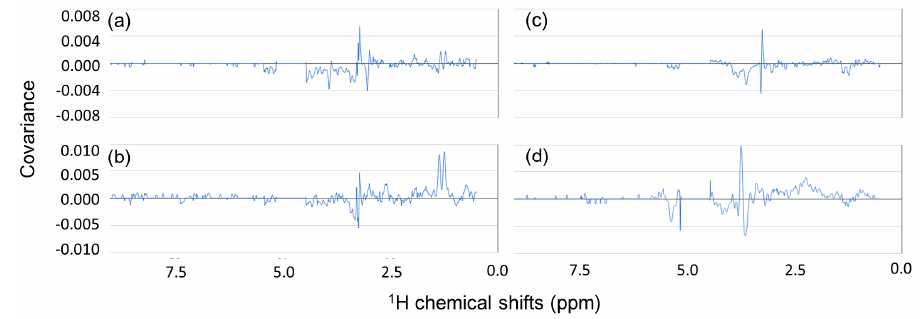
Figure 4. Covariance NMR spectra between chemical shifts and either tasting or